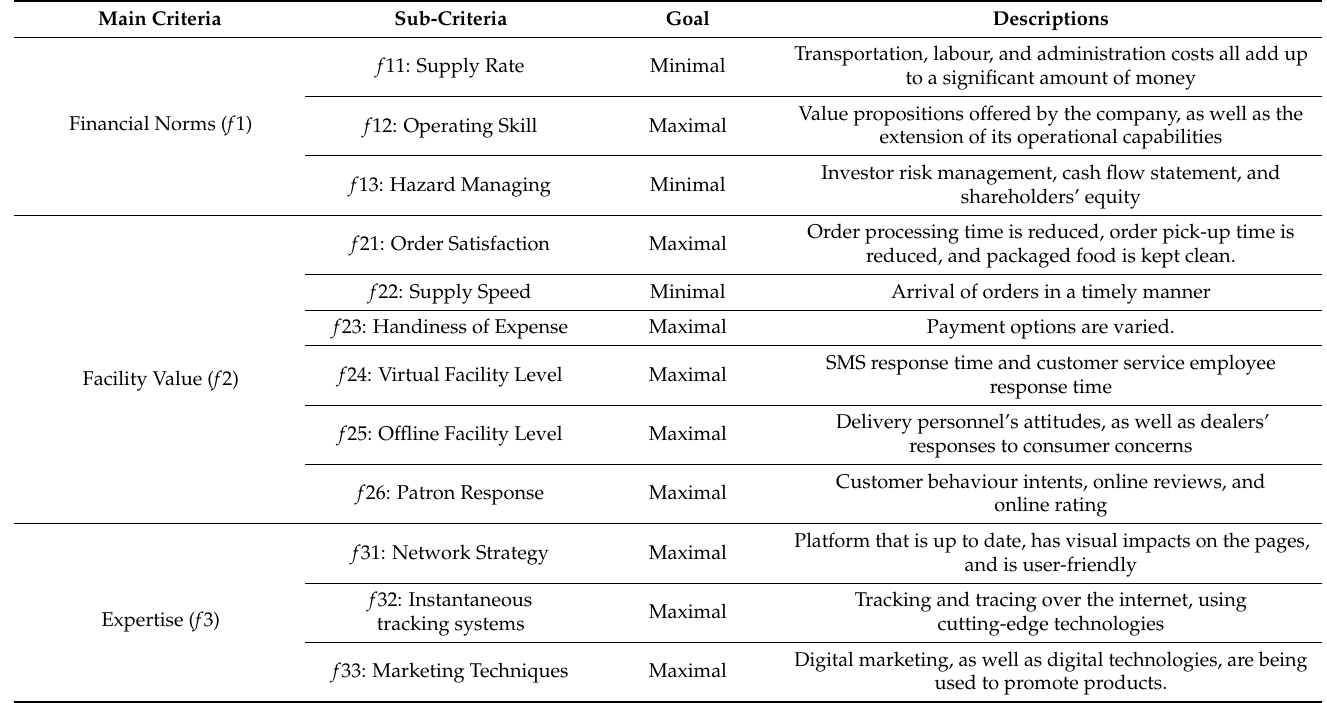
Table 1. Criteria for evaluating and describing sustainable online food